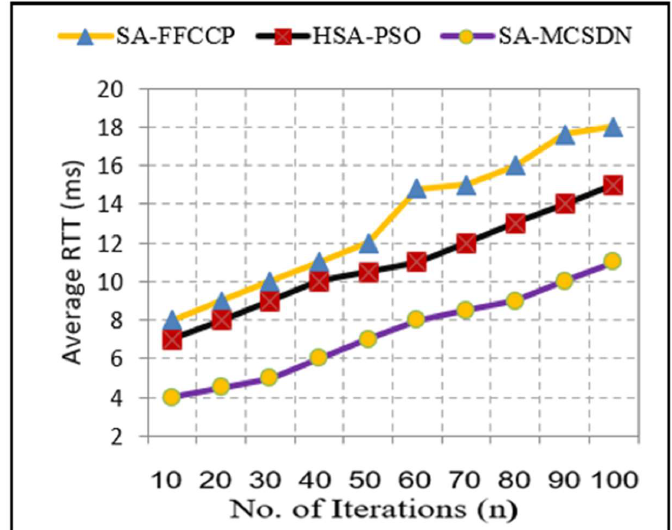
Figure 7. Comparison of average RTT.